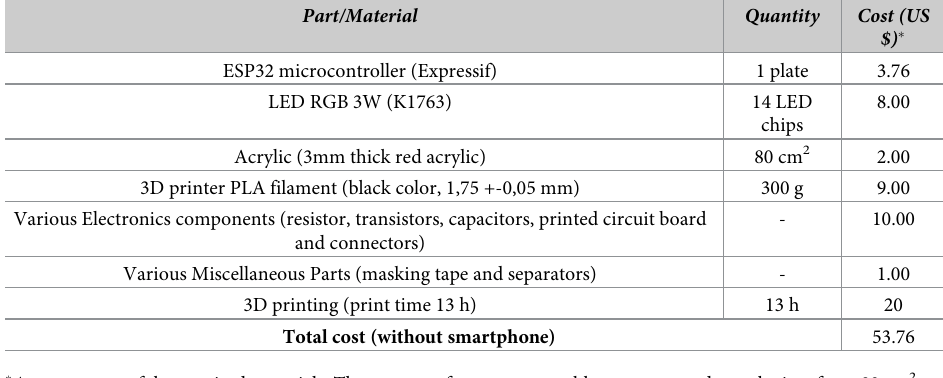
� Average costs of the required materials. These costs refer to a system able to accommodate gels sizes from 80 cm 2